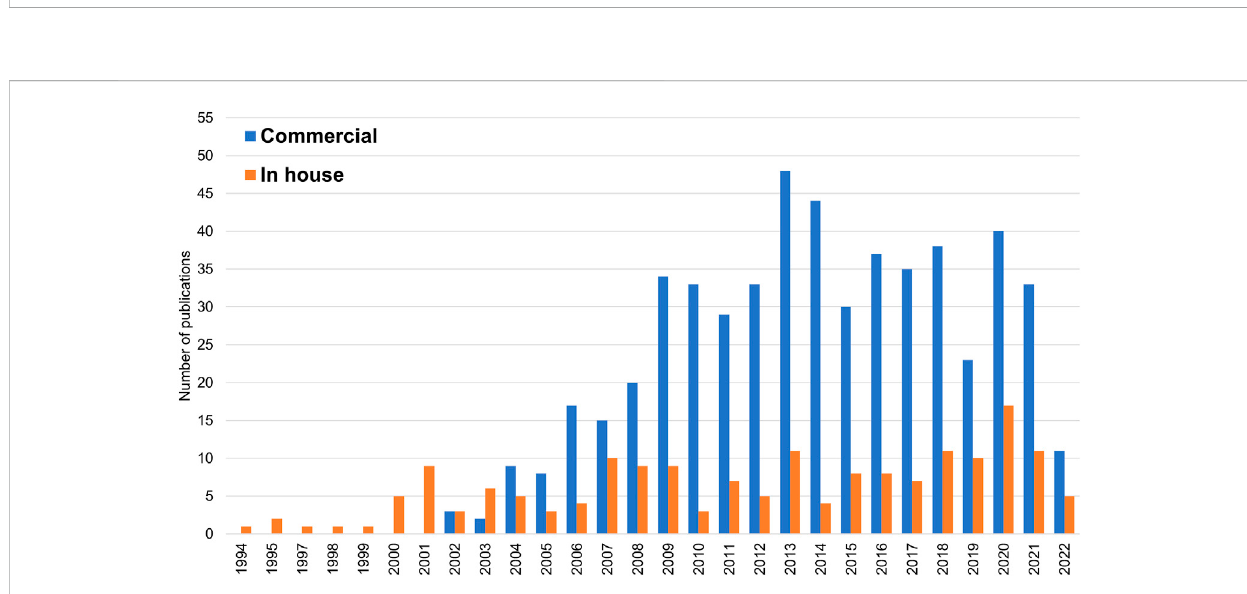
FIGURE 5 Number of publications per year on commercial and in-house BDD anodes in the degradation of contaminants, based on the bibliometric analysis search (source: the authors).